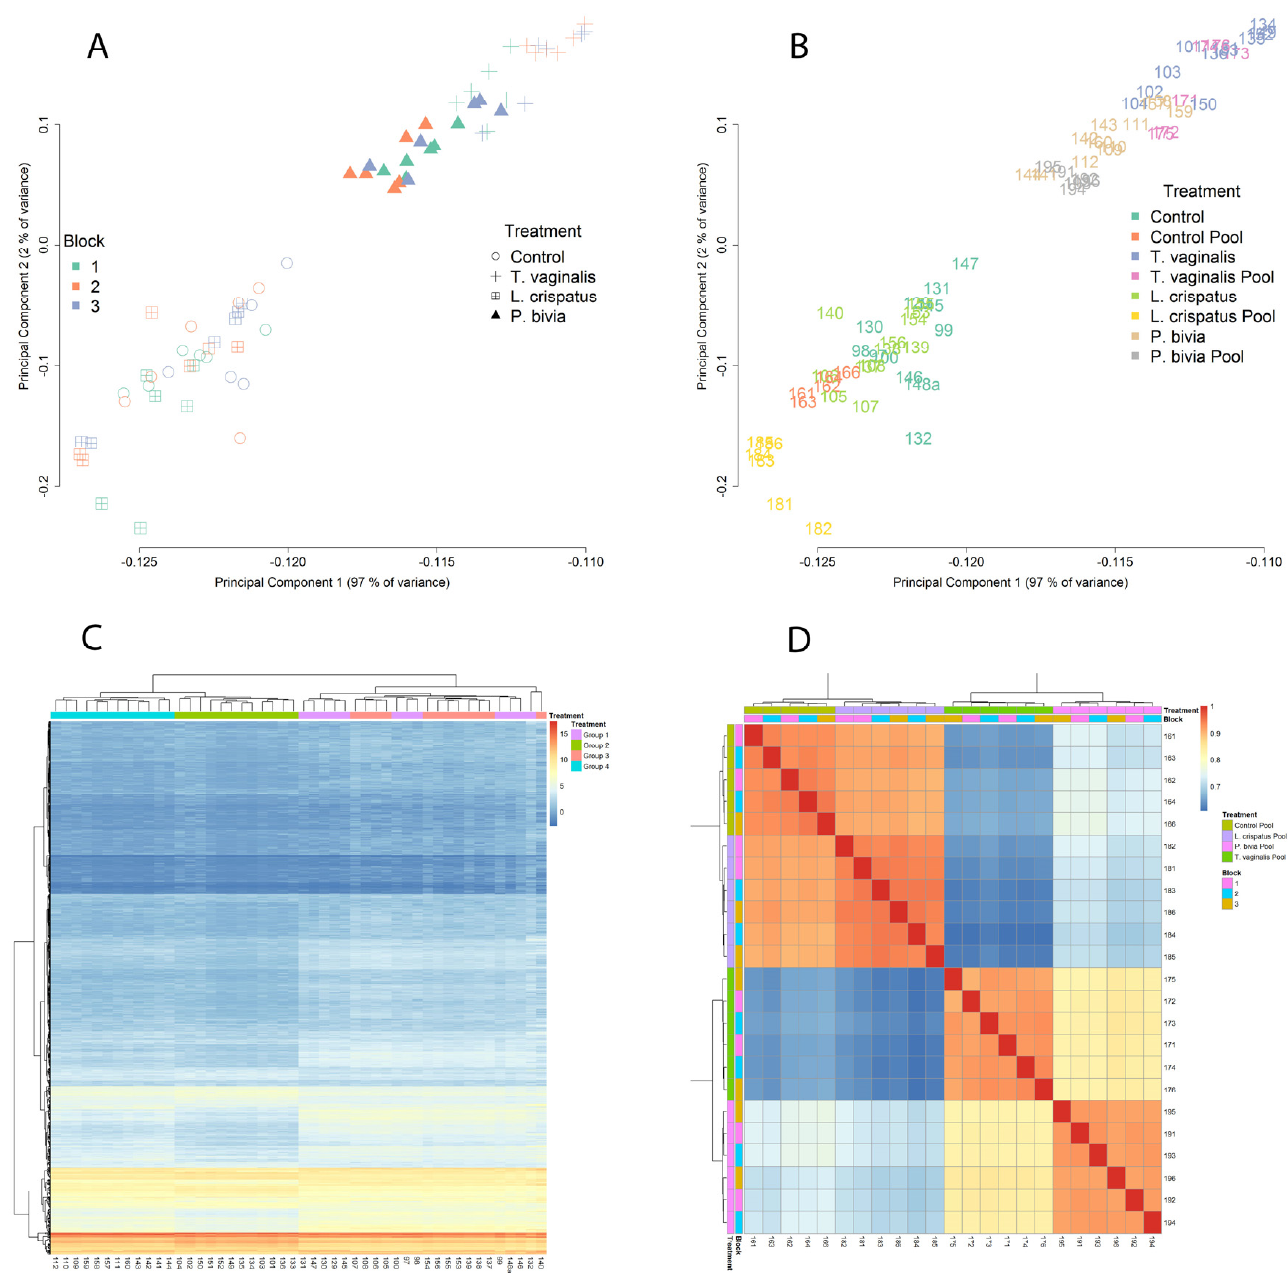
Figure 1. EV-miRNAs expression clustered by type of colonizing organism and differentiated pathogenic from homeostatic condition. Panels A and B illustrate multidimensional scaling. Bivariate plots of biological and technical replicates from 4 independent experiments colored by sequence run (blocks 1–3) ( A ) or by treatment category ( B ) show that the first principal component separates pathogenic ( T. vaginalis and P. bivia ) from homeostatic colonization ( L. crispatus ) and baseline control across the X axis and explains 97% of the variance in miRNA expression levels. Panels C and D visualize heatmaps where miRNA expression levels are depicted by variation in color intensity from red (up-regulated) to blue (down-regulated). A hierarchical clustering by treatment (groups 1–4) shows all replicates from control (group 1) and L. crispatus (group 3) clustering together and distinctly from T. vaginalis and P. bivia treatments (groups 2 and 4, respectively) ( C ). A heatmap of the top 500 differentially expressed miRNAs generated from pairwise correlation (Kendall tau) shows high correlation between technical replicates within all sequence runs and well-defined treatment clusters confirming the rigor of differentiating pathogenic from homeostatic conditions by EV-miRNA profiling ( D